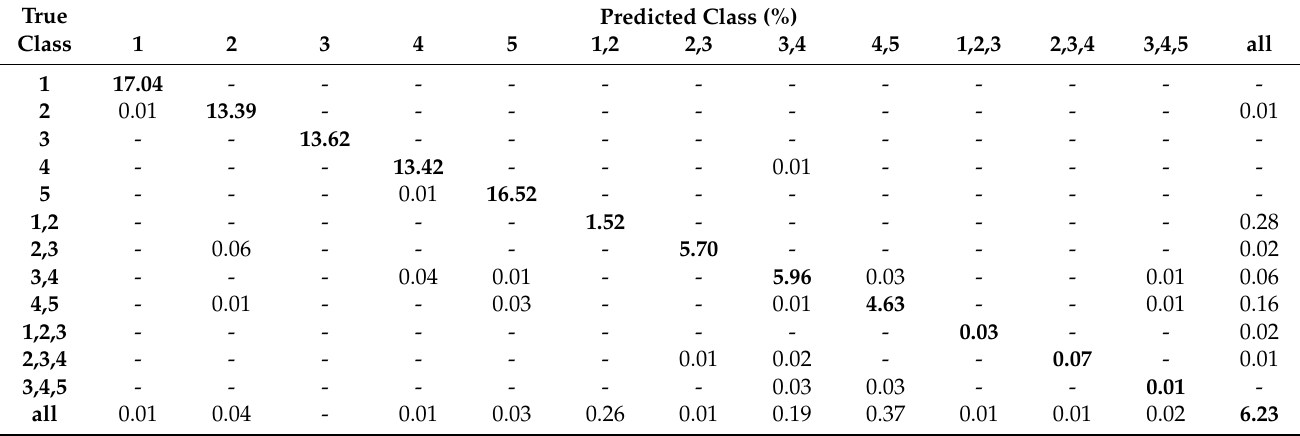
Table 6. Confusion matrix related to damaged compartments evaluated at 500 s. Training: MC20; validation: